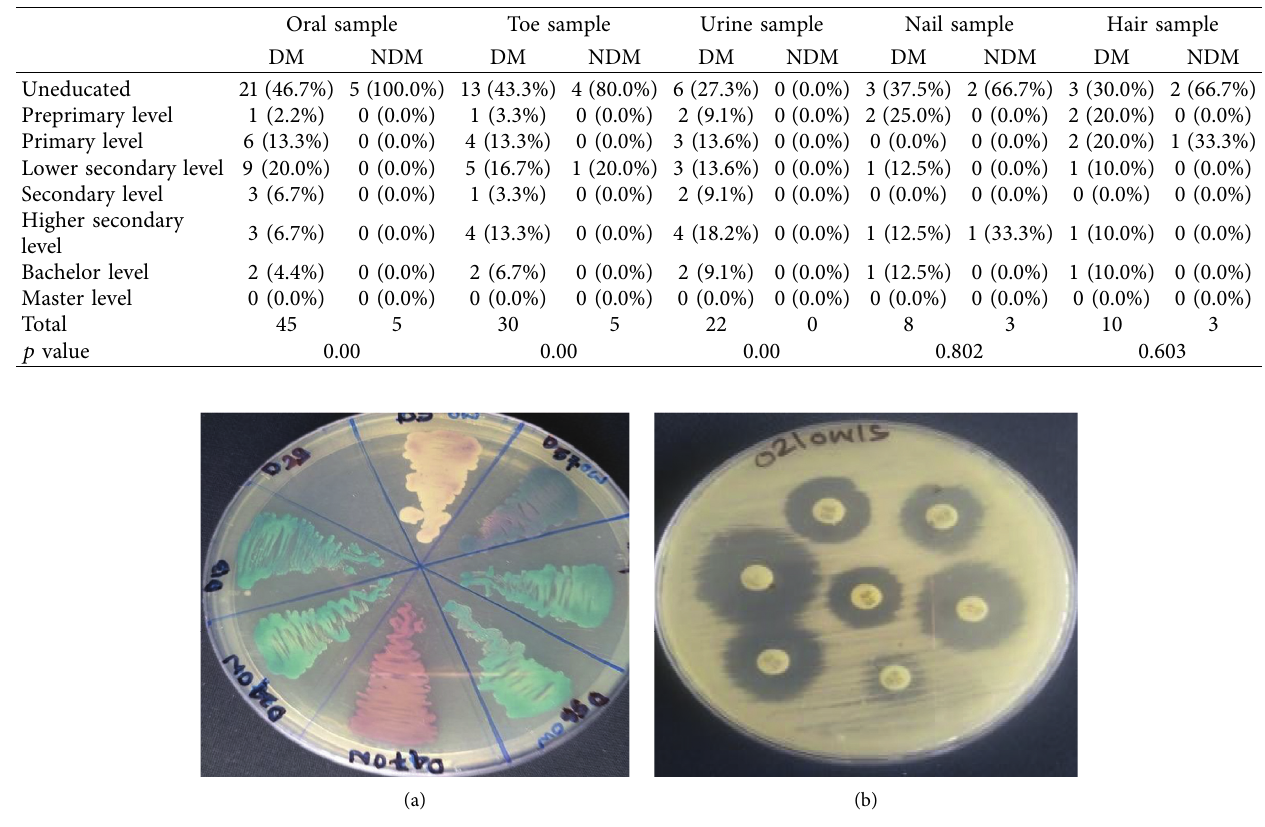
Figure 1: (a) Growth of Candida species in CHROMagar medium; (b) antibiotic susceptibility testing. Table 4: Antibiotic resistance pattern of Candida species isolated from both groups. Antifungal